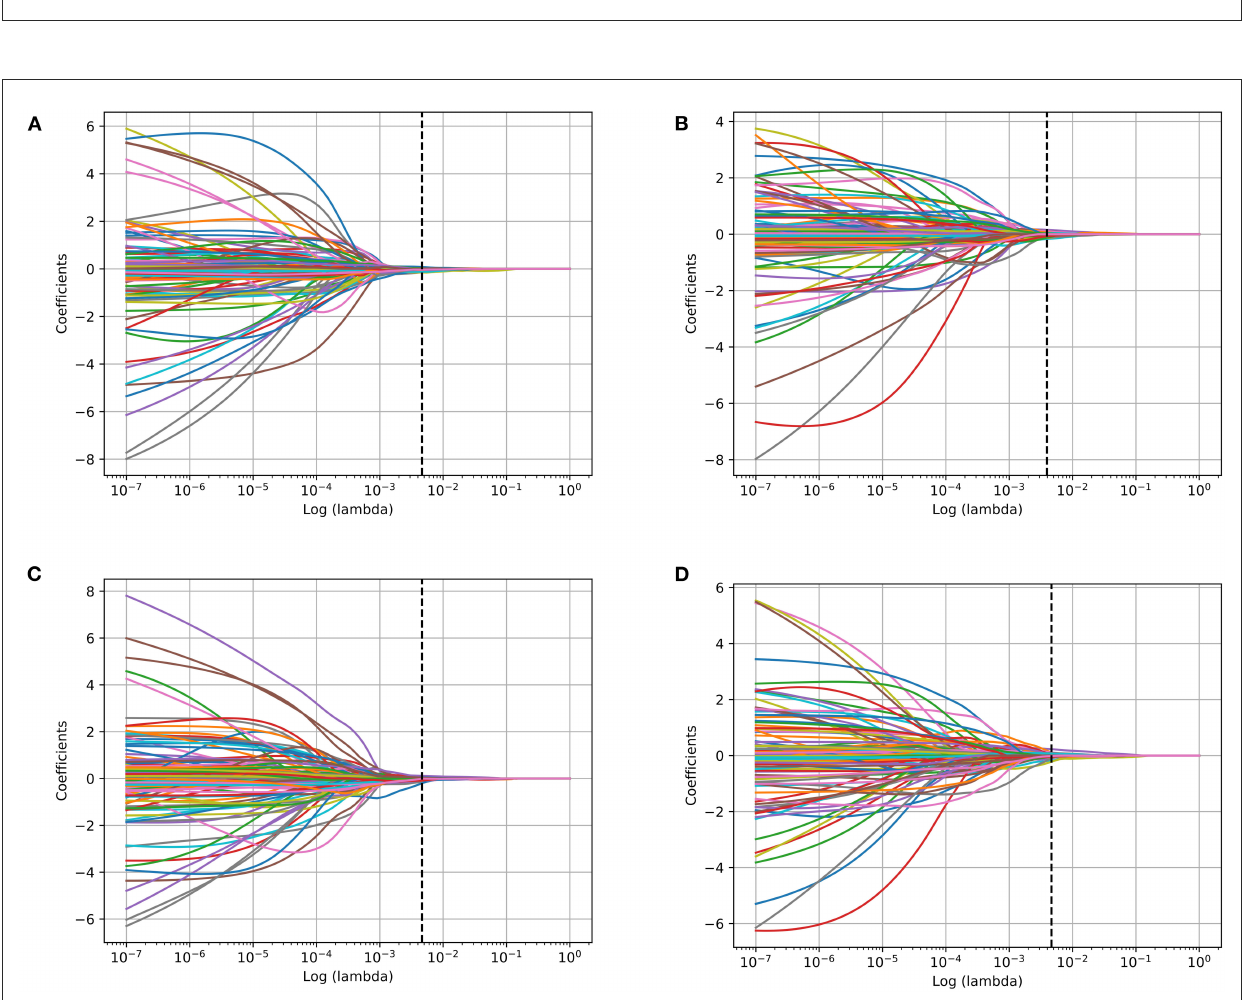
FIGURE2 Bilateral amygdala radiomics feature coefficients-lambda graph of the LASSO dimensionality reduction of different tasks. (A) Left amygdala features in Anxiety disorder vs. HC task; (B) right amygdala features in Anxiety disorder vs. HC task; (C) left amygdala features in GAD vs. HC task; (D) right amygdala features in GAD vs. HC